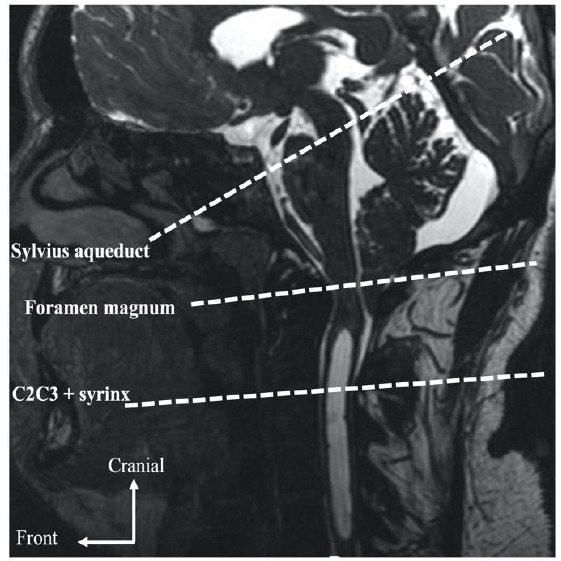
Figure 1. PCMRI acquisitions planes on sagittal T2